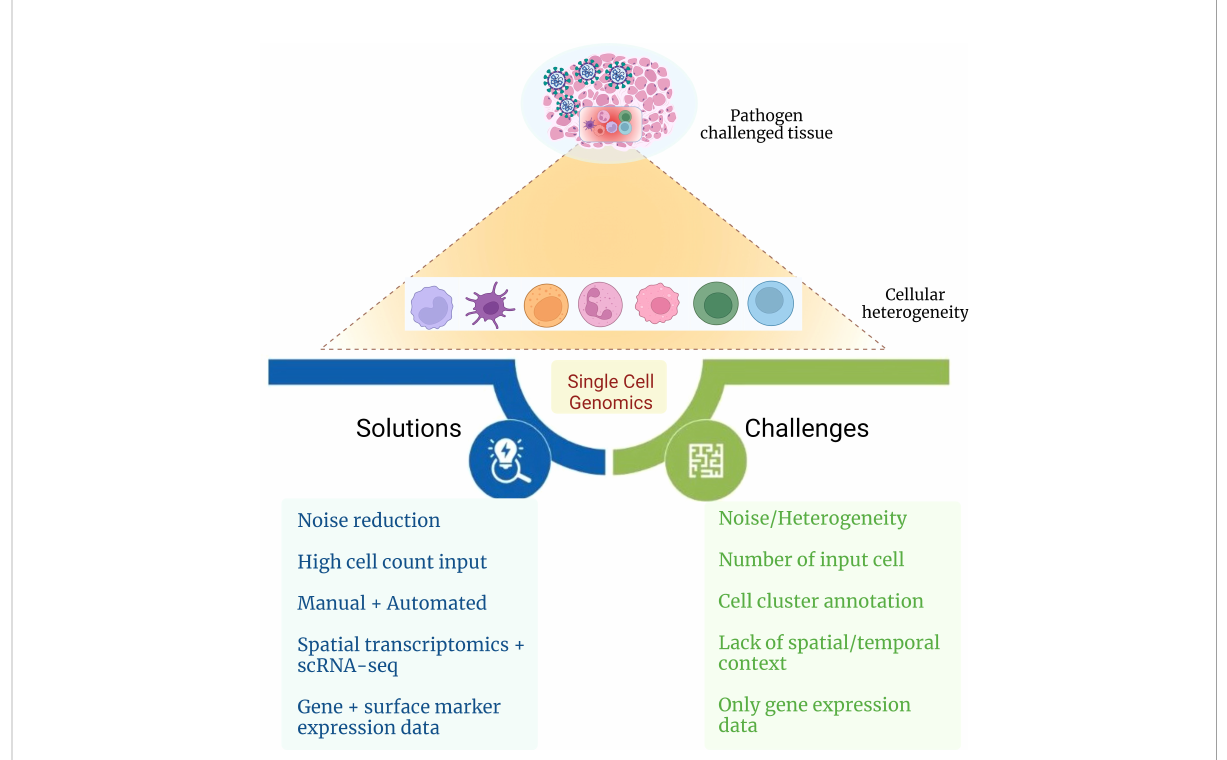
FIGURE 4 Challenges and possible solutions for delineating cellular heterogeneity. The fi gure captures challenges and possible solutions toward elucidating the role of cellular heterogeneity during infectious disease with the aid of single-cell genomics